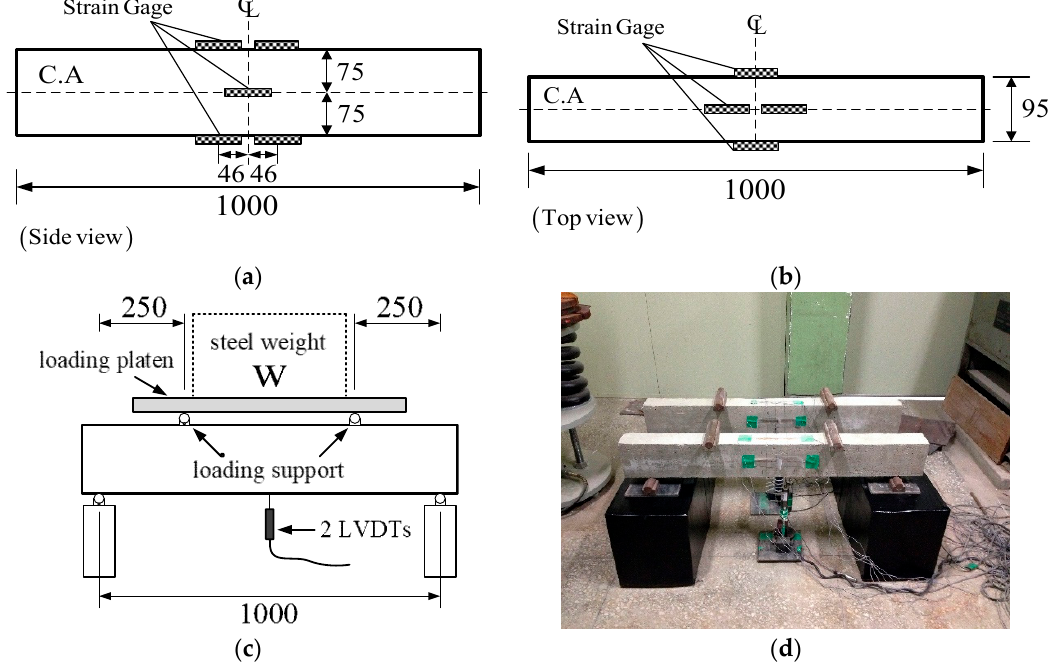
Figure 2. Beam creep tests: ( a ) locations of surface-attached strain gauges (side view), ( b ) locations of surface-attached strain gauges (top view), ( c ) four-point bending, and ( d ) beam creep test set-up (unit: mm).